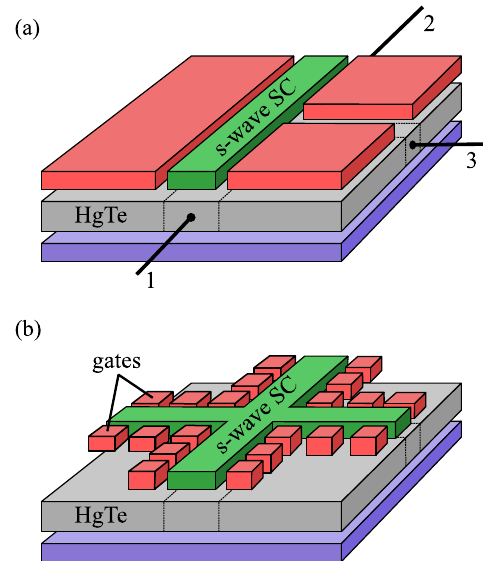
FIG. 8. (a) Multiterminal transport setup allowing for a refined detection of Majorana zero modes. A current through leads 1 or 2 allows one to probe the hallmark zero-bias anomaly stemming from Majoranas. To readily resolve the gap closure (and revival) that accompanies the onset of the zero-bias peak, transport can also be measured from lead 3 which probes the wire’s